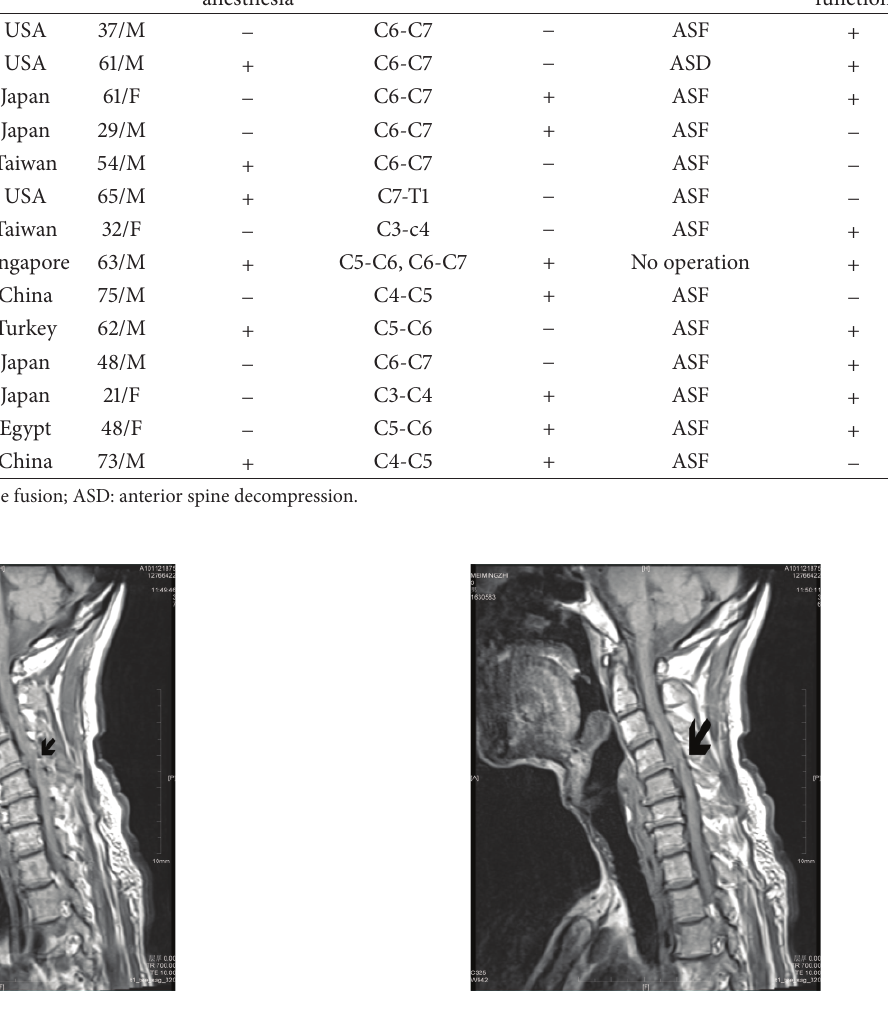
Figure 2: T2-weighted MRI demonstrates disc protrusion at C3- C4, C4-C5, and C5-C6, with spinal cord degeneration at 20 hours after gastrectomy. Arrow shows the lesion at the C4-5 level after the